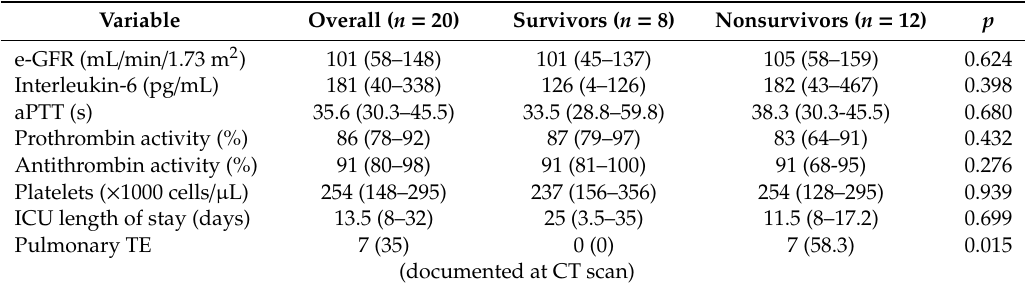
Table 2. Thrombin generation and fibrinolytic profile.